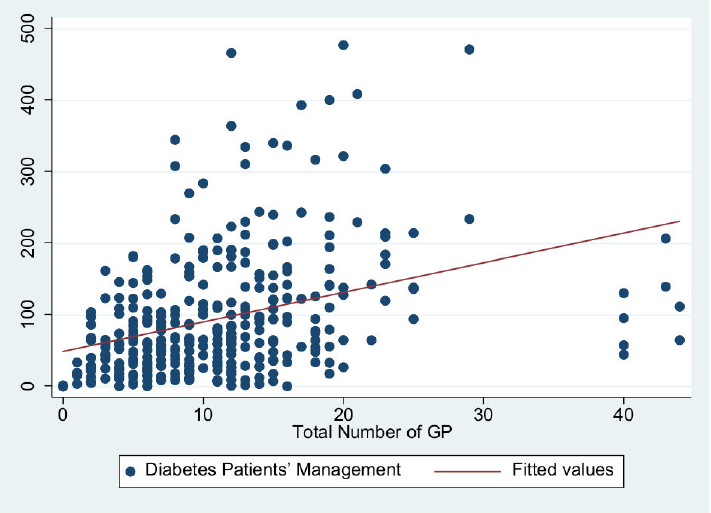
Figure 2. Scatter diagram of diabetes patient management and total number of